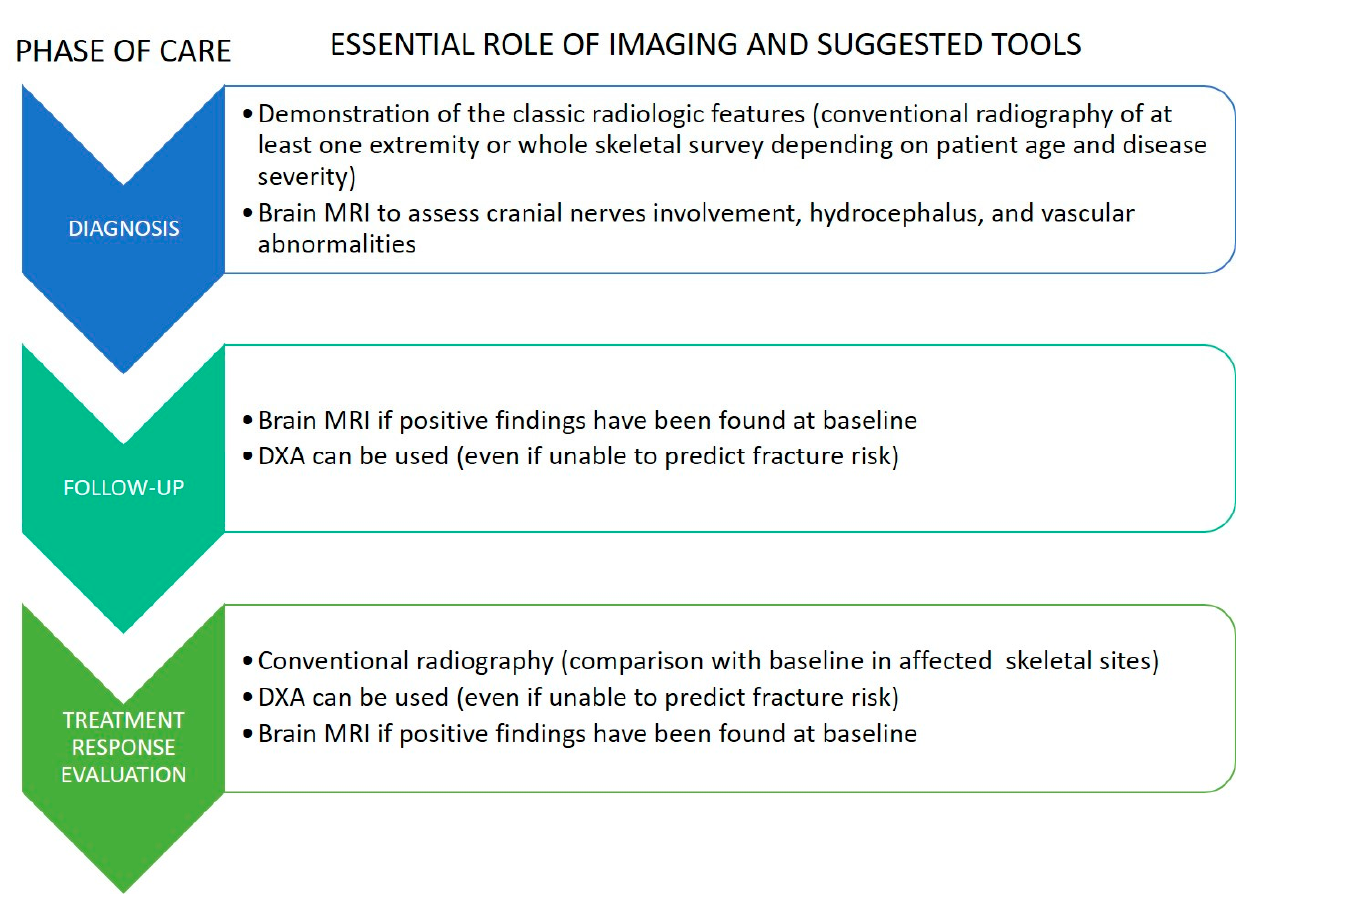
Figure 9. A general flow chart with a summary of essential imaging at each phase of osteopetrosis